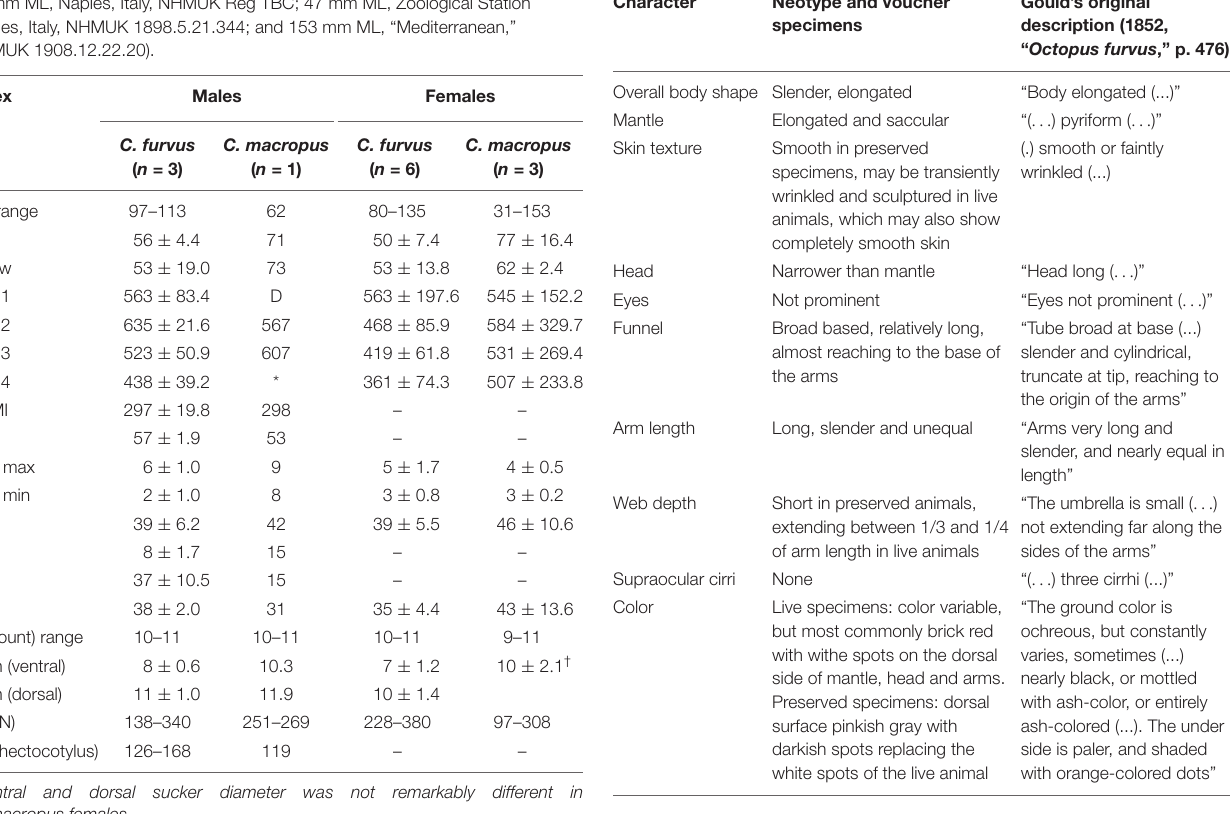
TABLE 7 | Comparison of some selected characters between Callistoctopus furvus new (present study) and original (Gould, 1852) description.